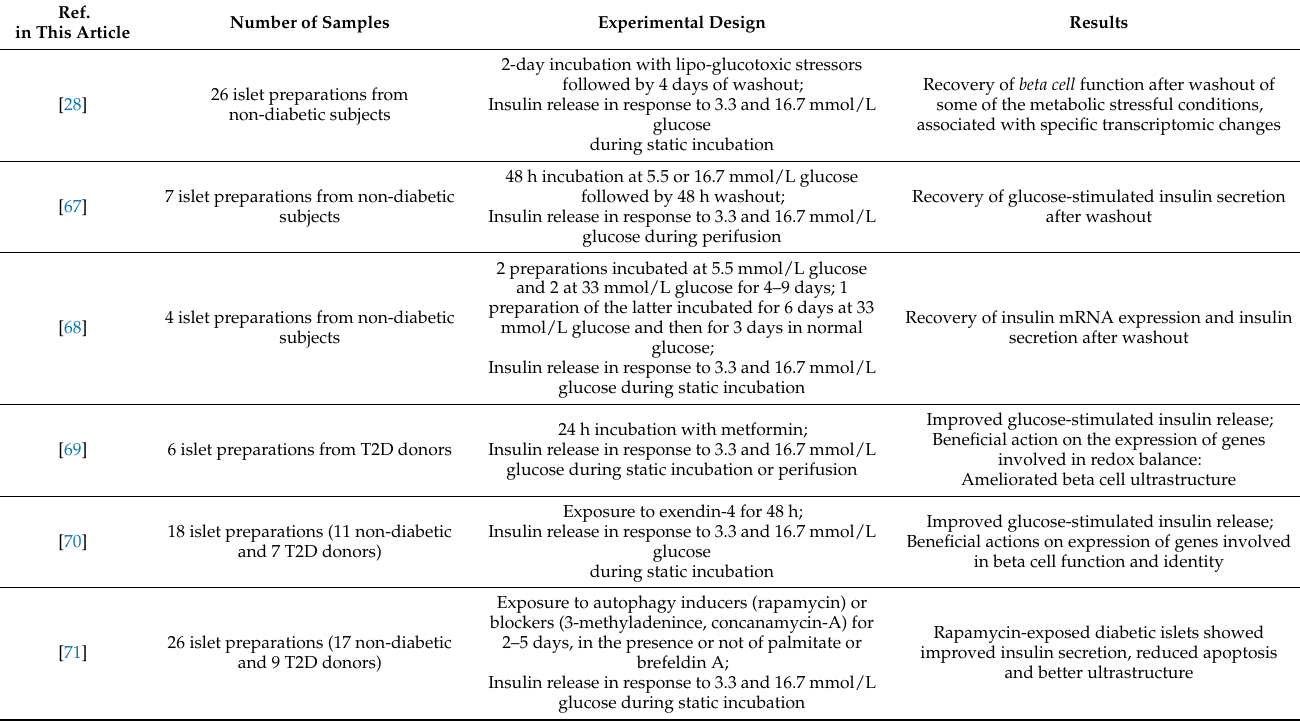
Table 3. Studies showing ex vivo recovery of beta cell